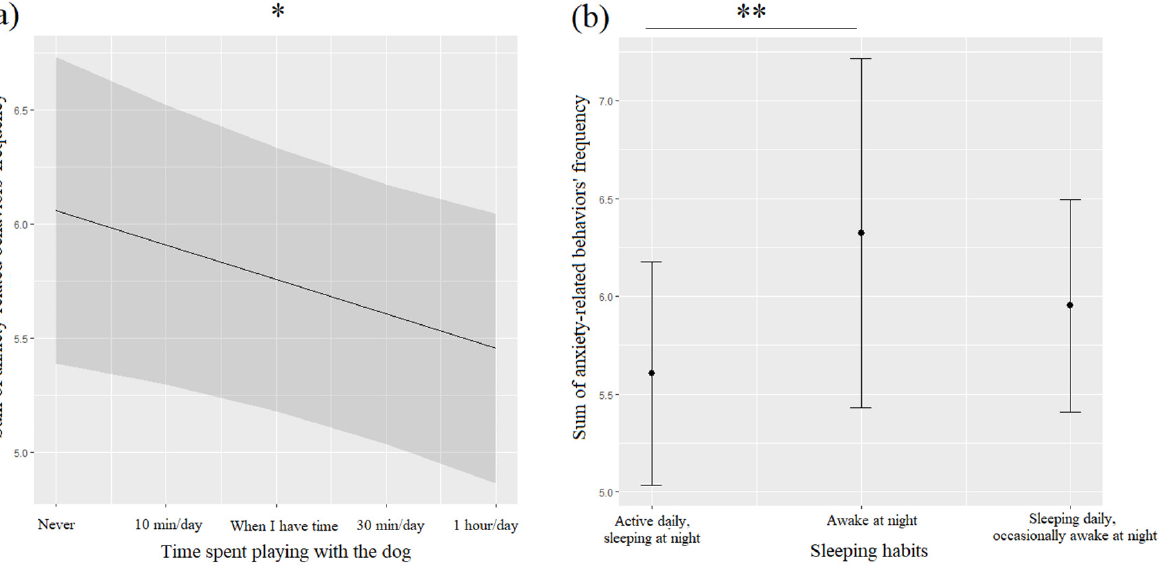
Figure 4. Means and 95% confidence intervals of dogs’ anxiety-related behaviors’ frequency depend- ing on the time spent by owners to play with dogs ( a ) and dogs’ sleeping habits ( b ) extracted from linear mixed-effect models (LMMs). *: p < 0.05; **: p < 0.01, Wald chi-squared tests with Bonferroni correction (significant results are bold: p <